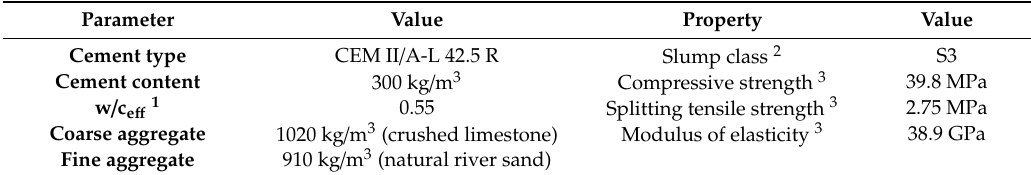
Table 2. Characteristics of the source